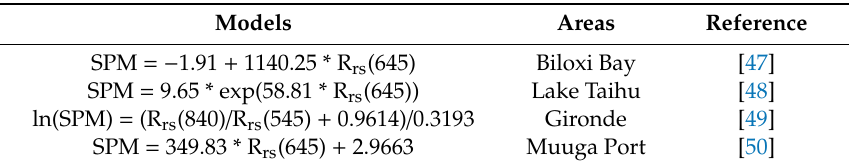
Table 3. General characteristics of SPM inversion